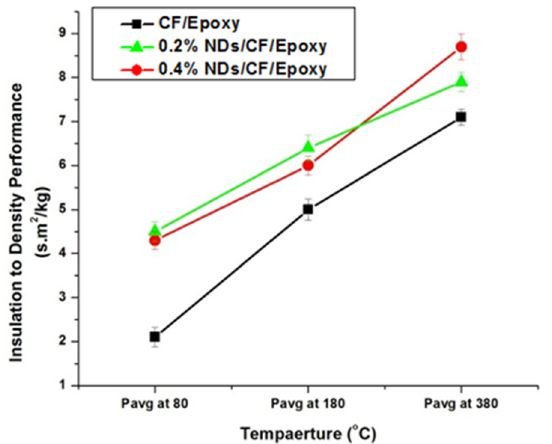
Figure 10. Insulation index performance of CFRE-C specimens at temperatures 80 ◦ C, 180 ◦ C, and 380 ◦ C.